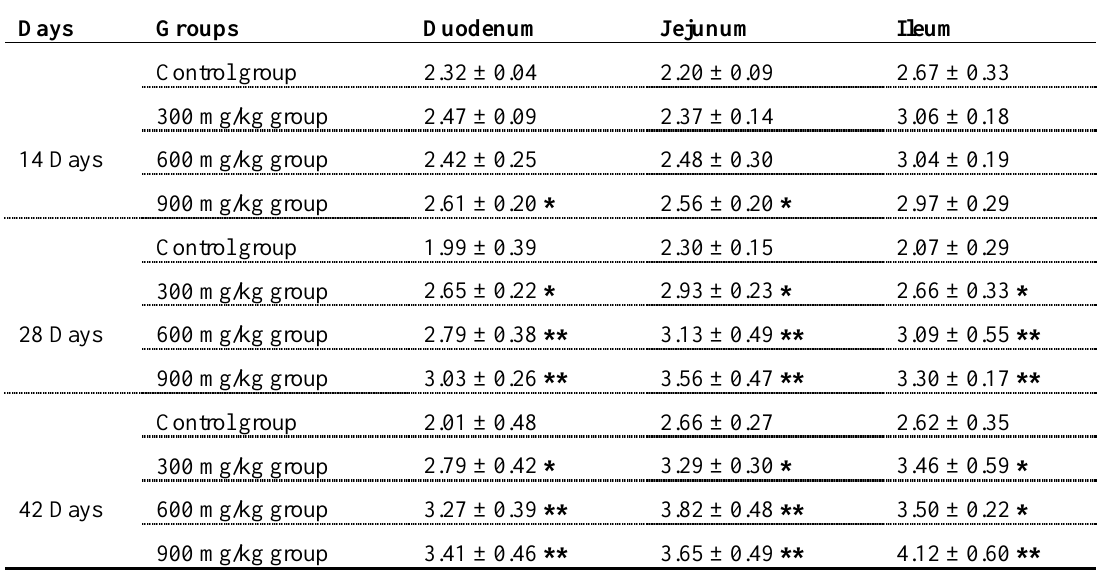
Table 6. Change of the MDA content (nmol/mgprot) in the intestinal